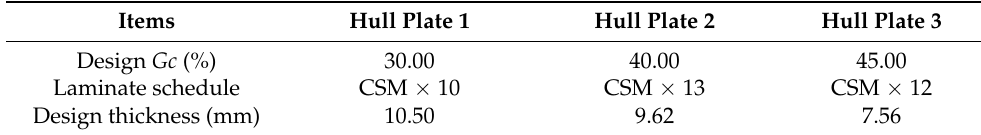
Table 1. Design details of specimens in the Gc variation group.